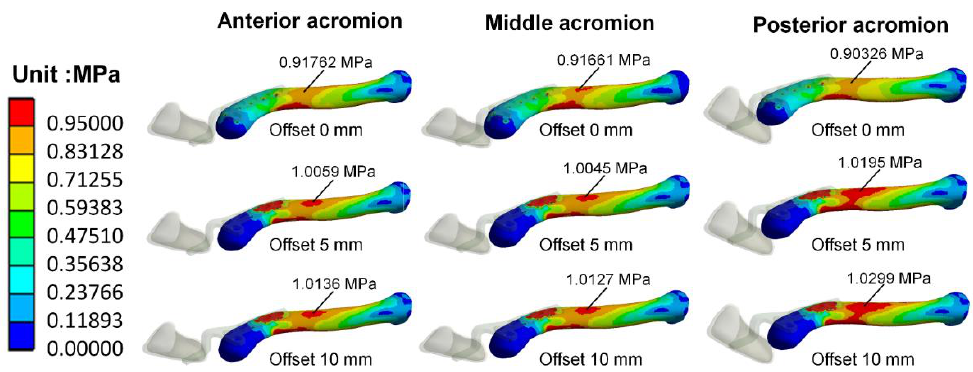
Figure 7. The distribution of von Mises stress on the clavicle.